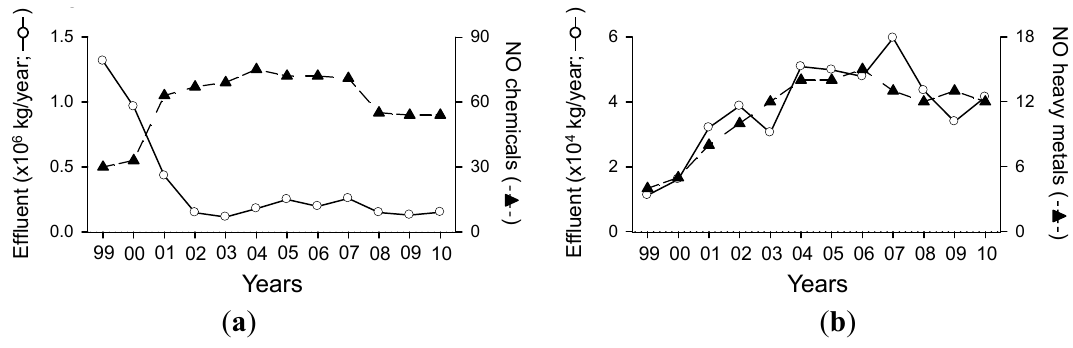
Figure 1. Annual changes of effluent volumes and the number of chemicals released to public waters from 1999 to 2010. ( a ) All chemicals and ( b ) heavy